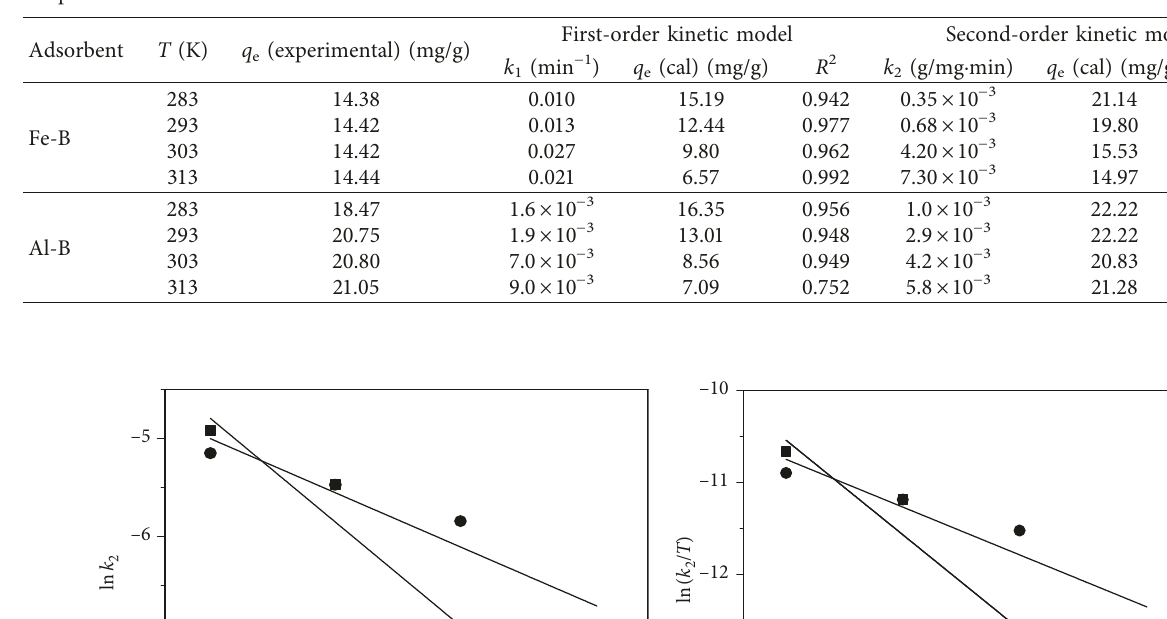
Figure 10: The pseudo - first-order kinetic model (a) and pseudo-second-order kinetic model (b) of As(V) adsorption by Al-B at different temperatures. Table 3: Parameters of pseudo - first-order and pseudo - second-order kinetic model of As(V) adsorption by Fe-B and Al-B at different temperatures.